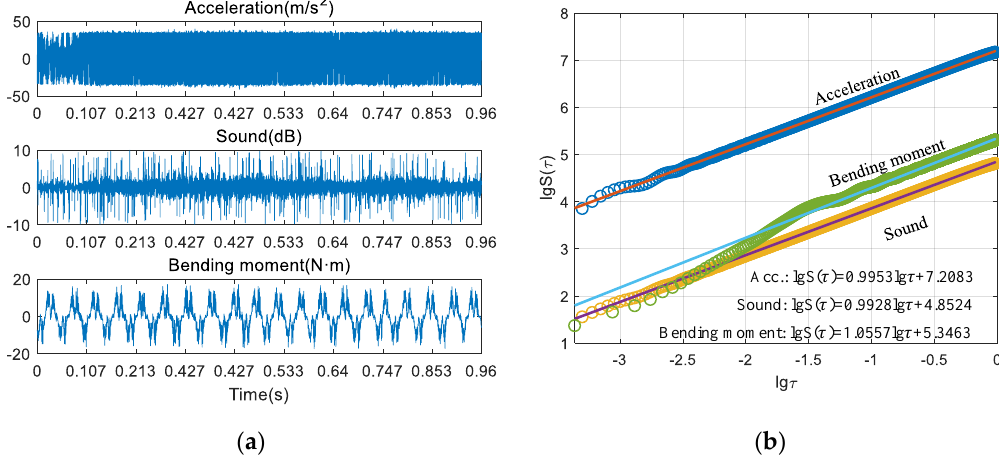
Figure 4. Calculation of the fractal dimension of the chatter condition. ( a ) aquired signals; ( b ) process of calculating fractal dimension.